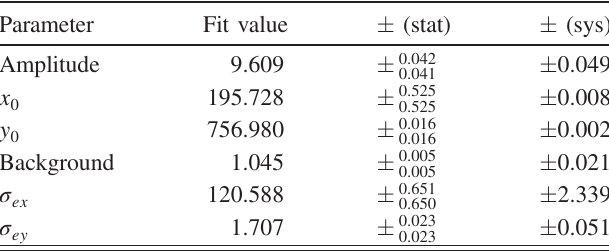
TABLE IV. Parameters from fitting multiple laserwire scans. The first uncertainty is the asymmetric statistical uncertainty from the fit and the second is the associated systematic uncertainty.